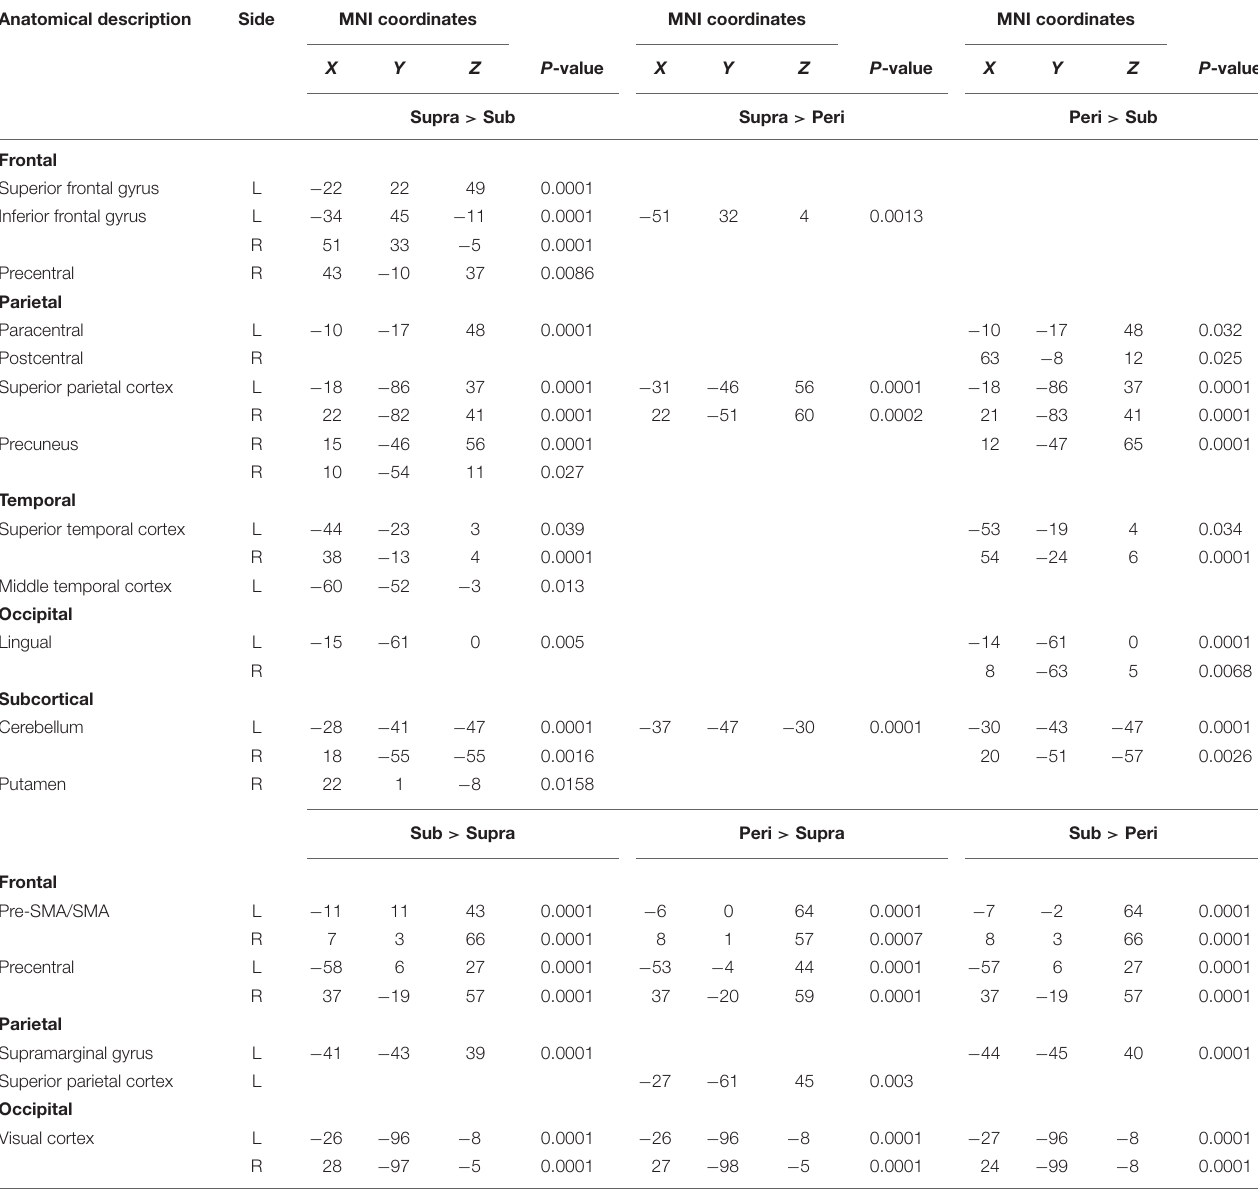
TABLE 1 | Brain regions significantly activated by either sub-, peri-, or supra-second timing. Anatomical